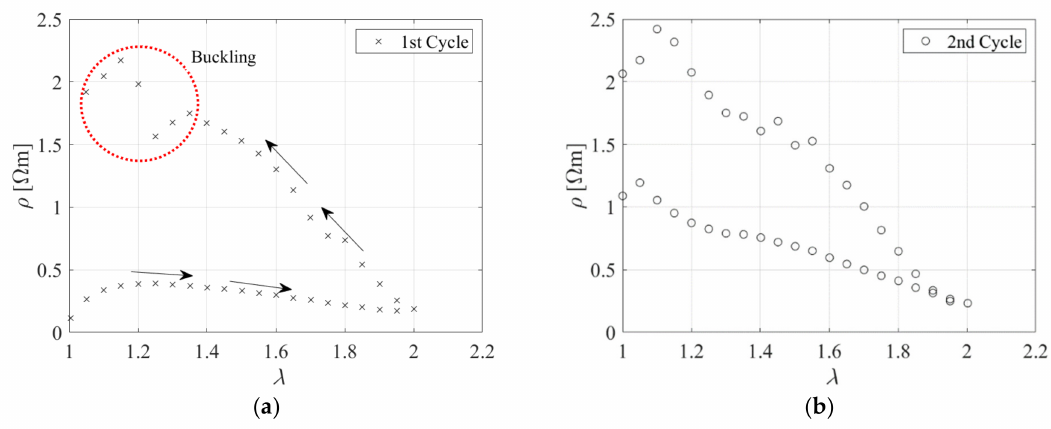
Figure 7. Resistivity as a function of the extension ratio during the ( a ) 1 st cycle and ( b ) 2nd